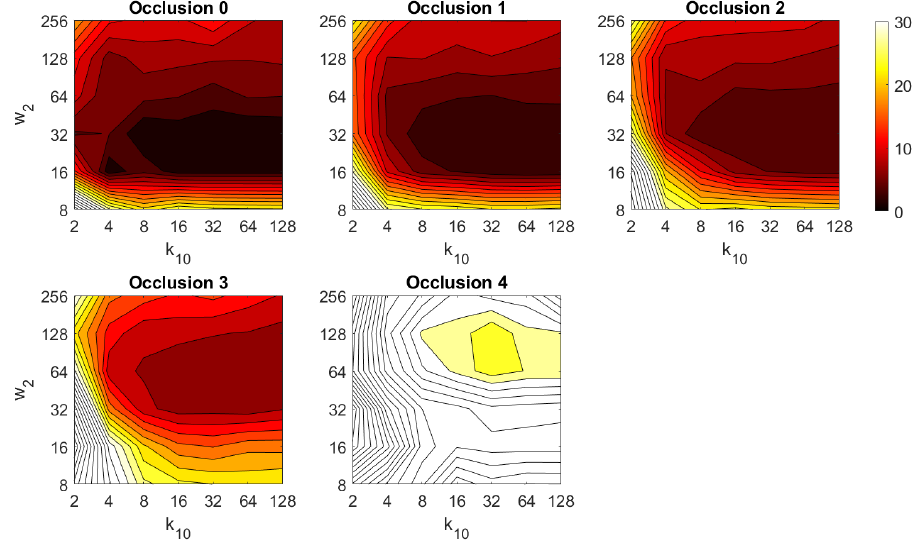
Figure 42. BG orientation estimation in the presence of occlusion. Average orientation error (deg).